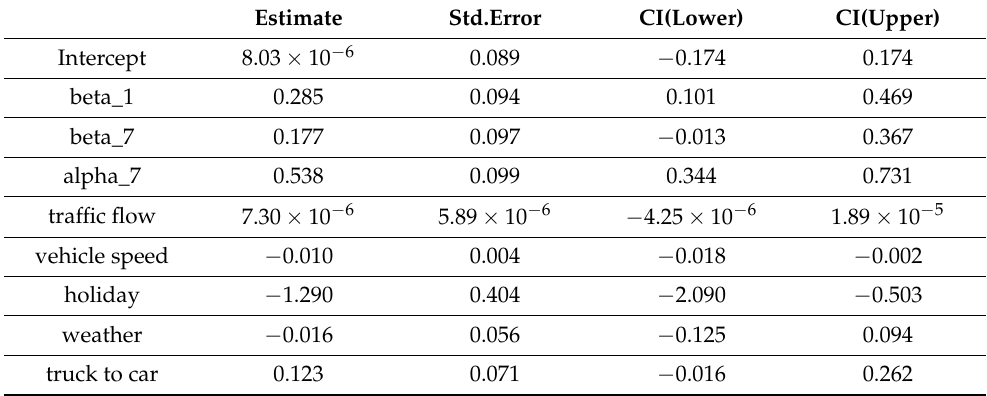
Table 5. Summary statistics for Negative Binomial Model in Nantung direction.